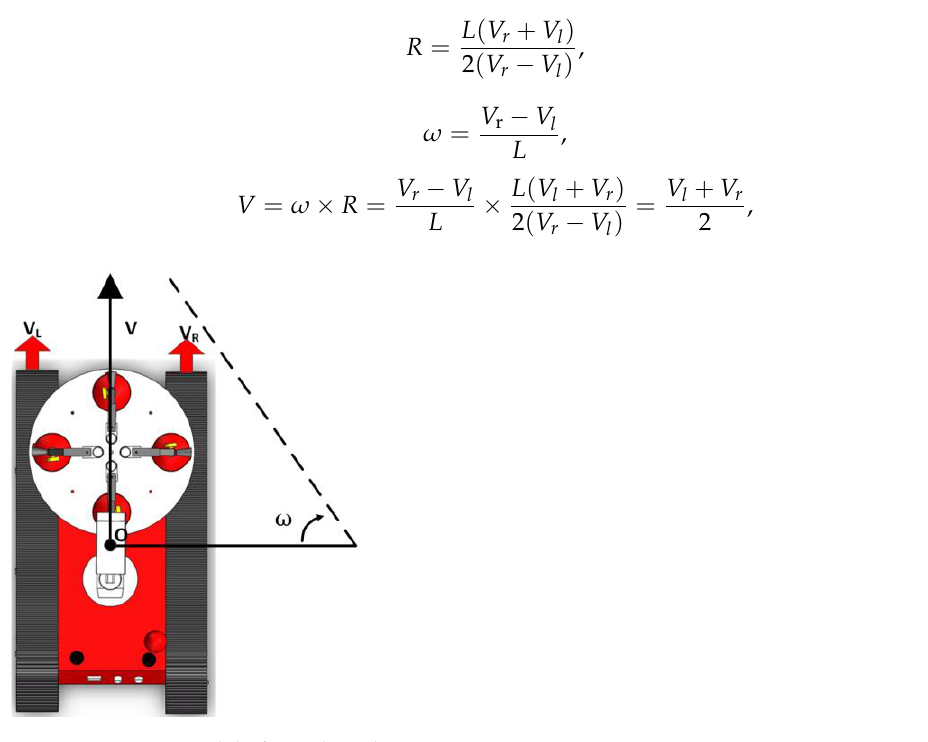
Figure 9. Motion model of crawler robot.